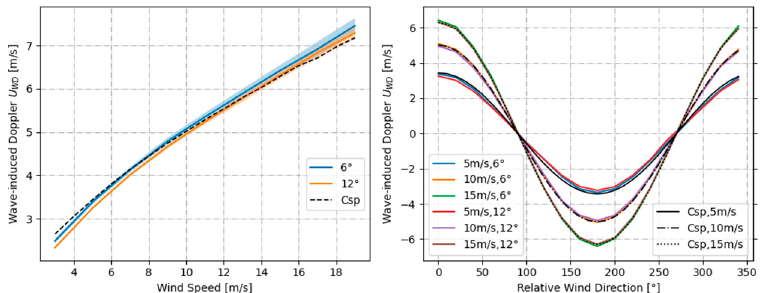
Figure 13. A comparison of the average specular scattering point velocity Csp with simulation re- sults at various wind speeds and relative wind directions. at various wind speeds and relative wind